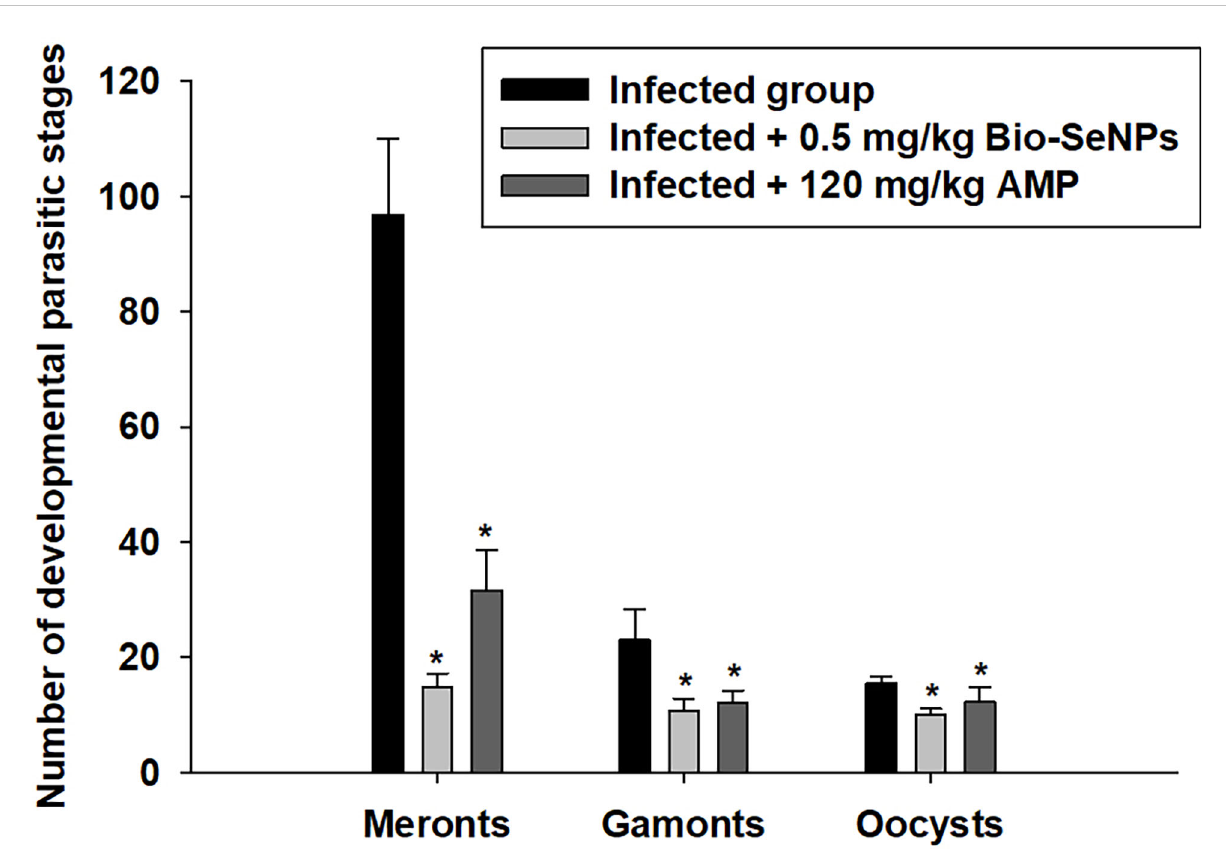
FIGURE 5 The number of developmental parasitic stages of Eimeria papillata in jejunum among the infected and treated groups. All values are means ± SD. * signi fi cance (P ≤ 0.05) between the infected and treated